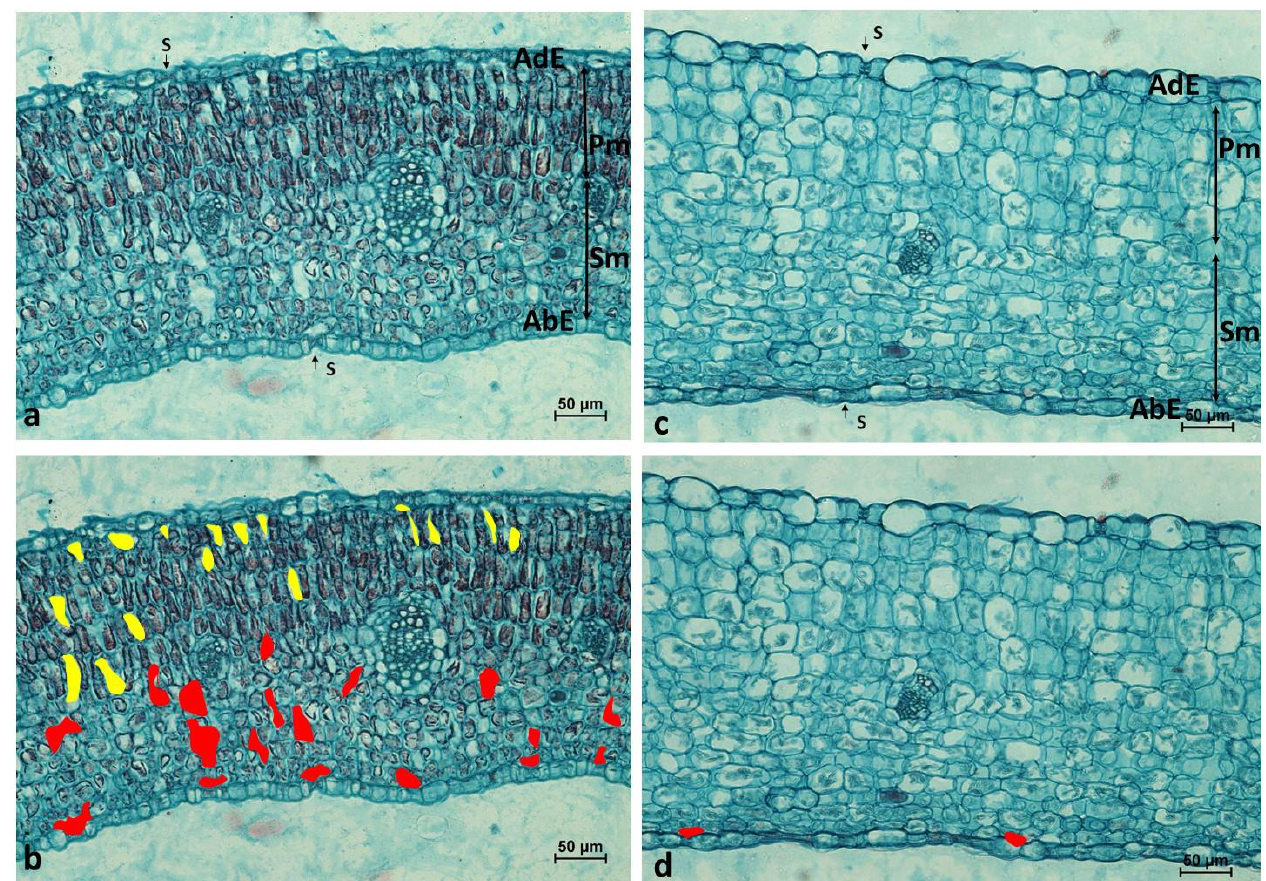
Figure 7. Cross-section of savoy cabbage leaves stained with safranin-fast green and imaged with light microscopy. ( a , b ) cultivar “Gloriosa”— susceptible to the cabbage whitefly, ( c , d ) cultivar “Alcosa”— resistant to the cabbage whitefly, ( b , d ) visualization of intercellular spaces in palisade mesophyll (yellow) and spongy mesophyll (red). Abbreviations: AdE—adaxial epidermis, AbE—abaxial epidermis, Pm—palisade mesophyll, Sm—spongy mesophyll, S—stomata.